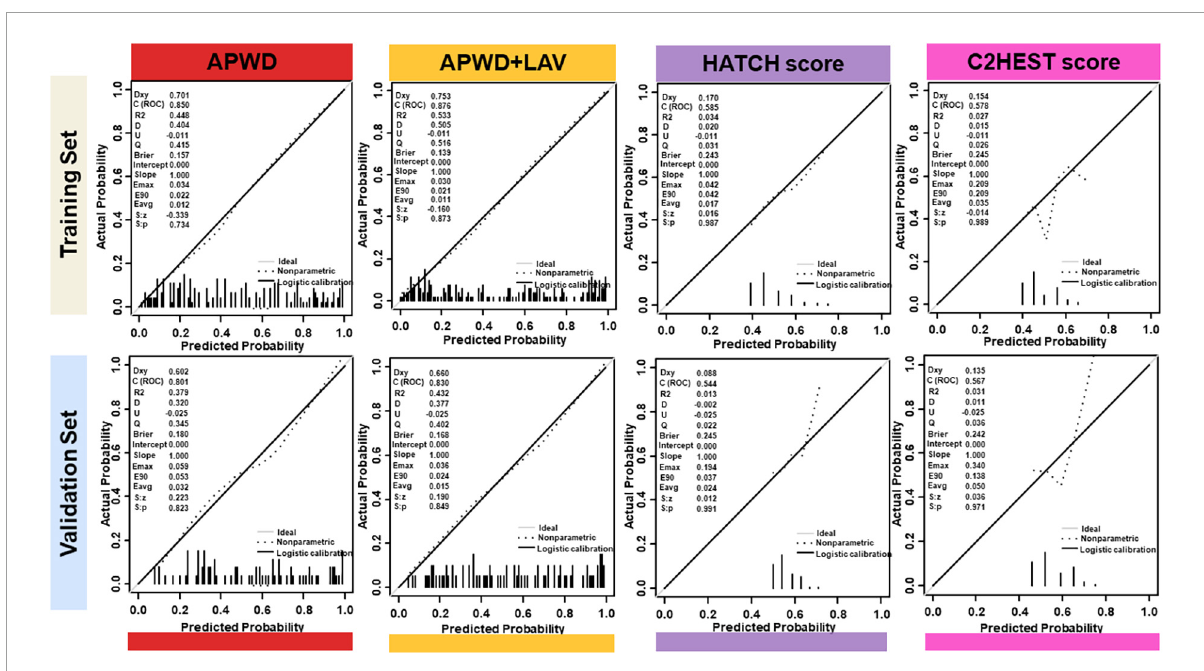
FIGURE6 Calibration plots of integrated model (APWD + LAV), APWD, HATCH score and C2HEST score in training (upper) and validation (lower) sets. The diagonal gray line indicates perfect prediction of the ideal model. The dashed line represents the performance of the model, the dark solid line represents the calibrated model performance and being closer to the diagonal gray line indicated that the model has better prediction ability. In the left upper corner, different parameters are listed to provide more information of models including Dxy, ROC (equals to 1/2Dxy + 0.5), R2 and Brier Score. LAV, left atrial volume; APWD, duration of the amplified digital P-wave.